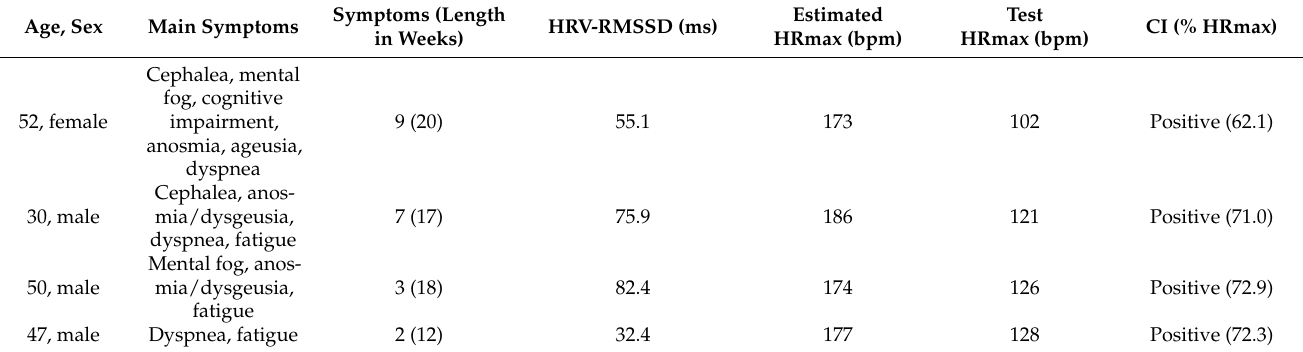
Table 2. Patients with post-COVID-19 syndrome and chronotropic